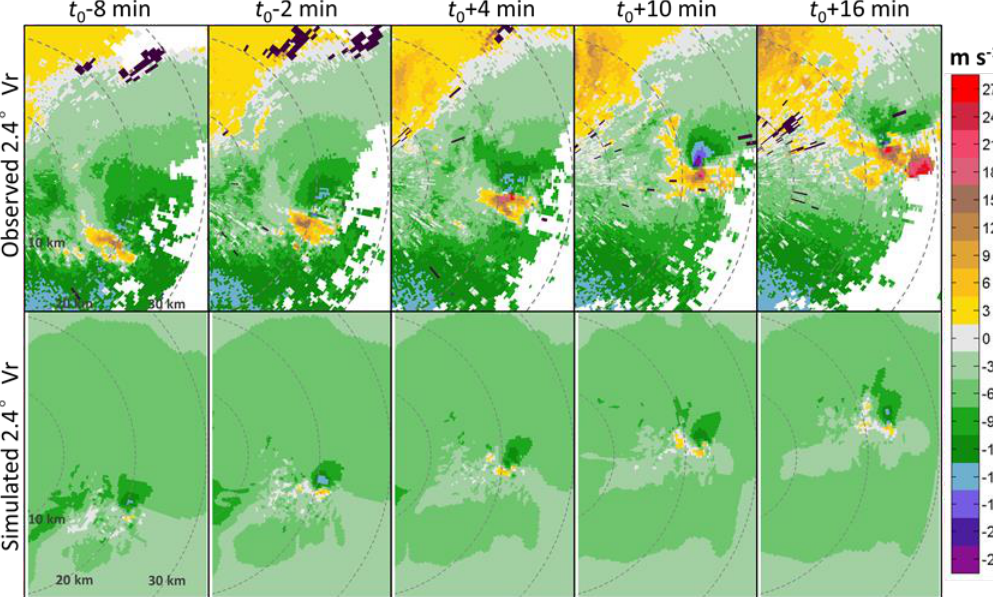
Figure 3. As in Figure 2 but for radial velocity (Vr).